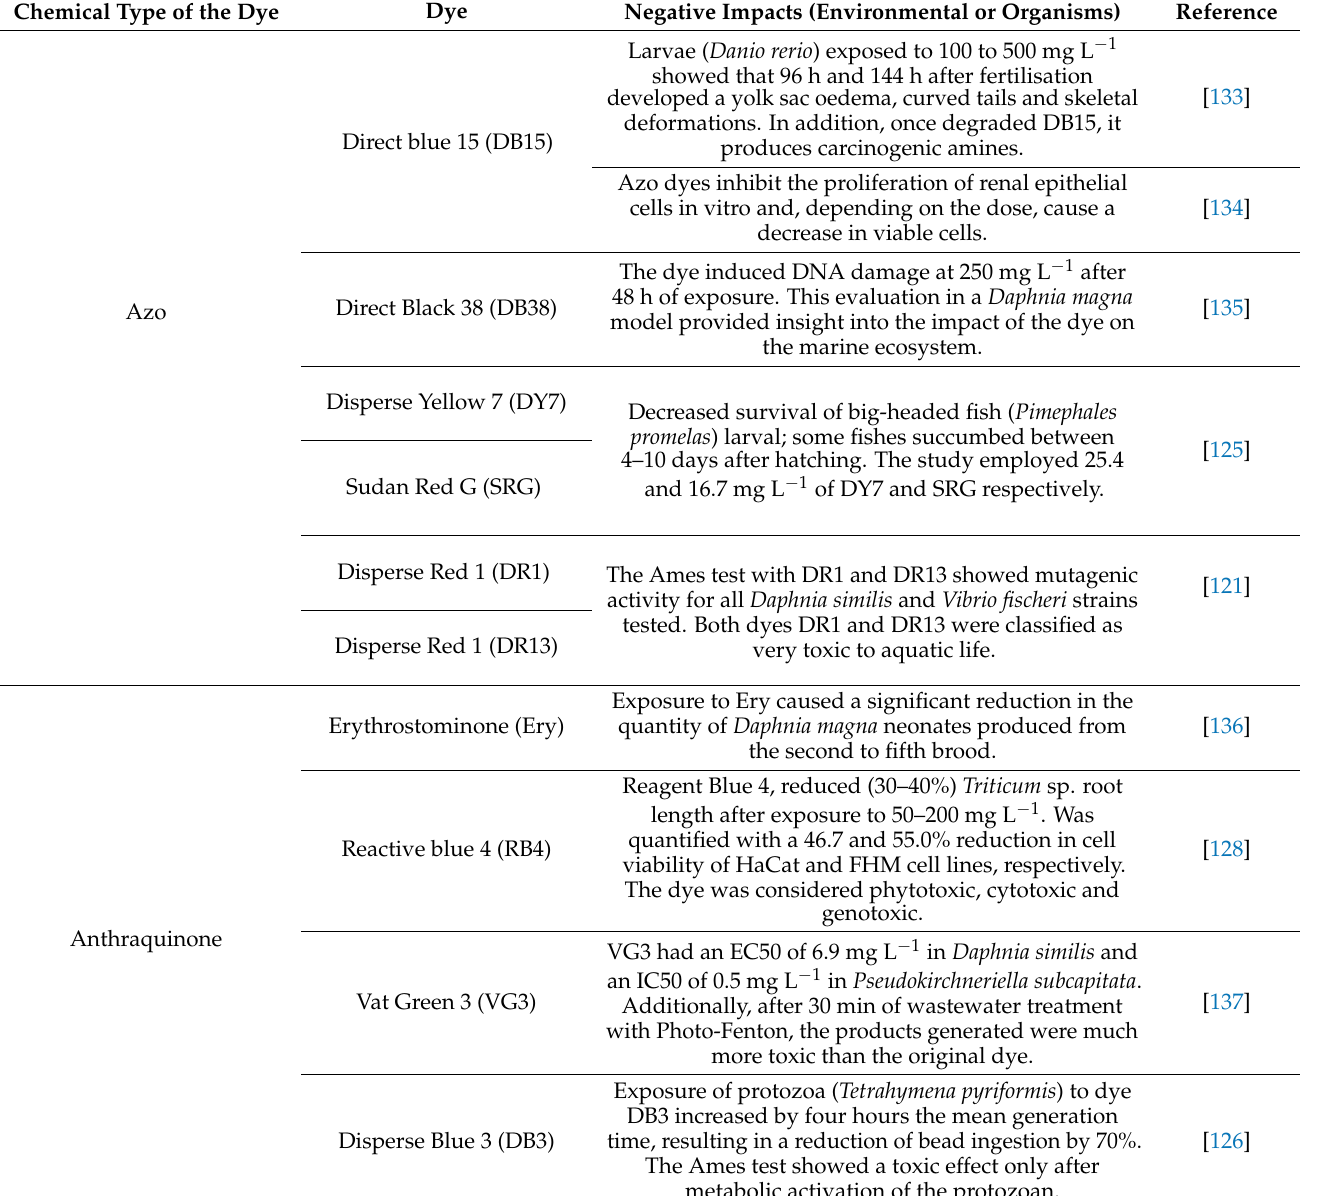
Table 3. Negative impacts of azo dyes, anthraquinones and triphenylmenthane on wildlife and or cell cultures. Chemical Type of the